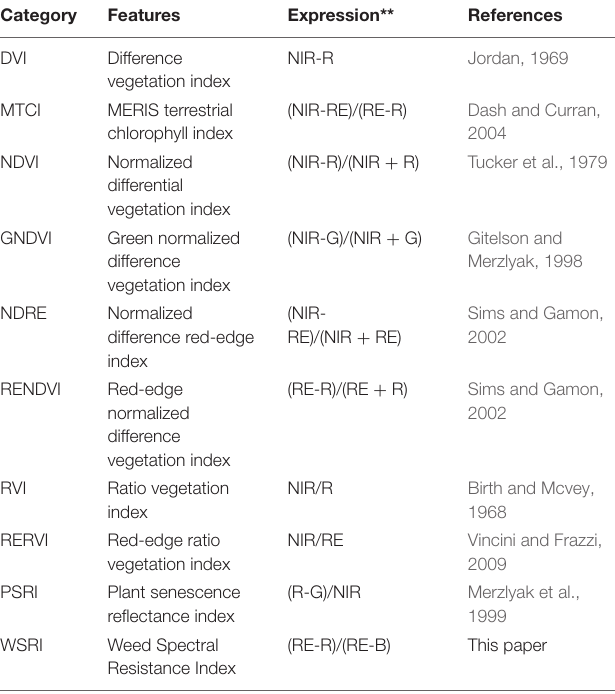
TABLE 3 | Vegetation indices used in this study.